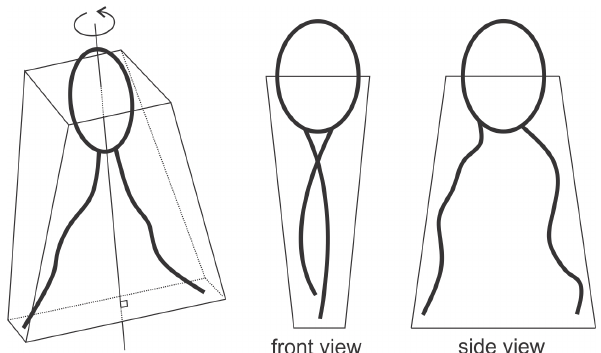
Figure 4. In-plane orientational order within the membranes of red blood cells or extracellular vesicles could arise due to V-shaped stretched chains of phospholipids. Adapted with permission from ref. [137]. 2019 Springer